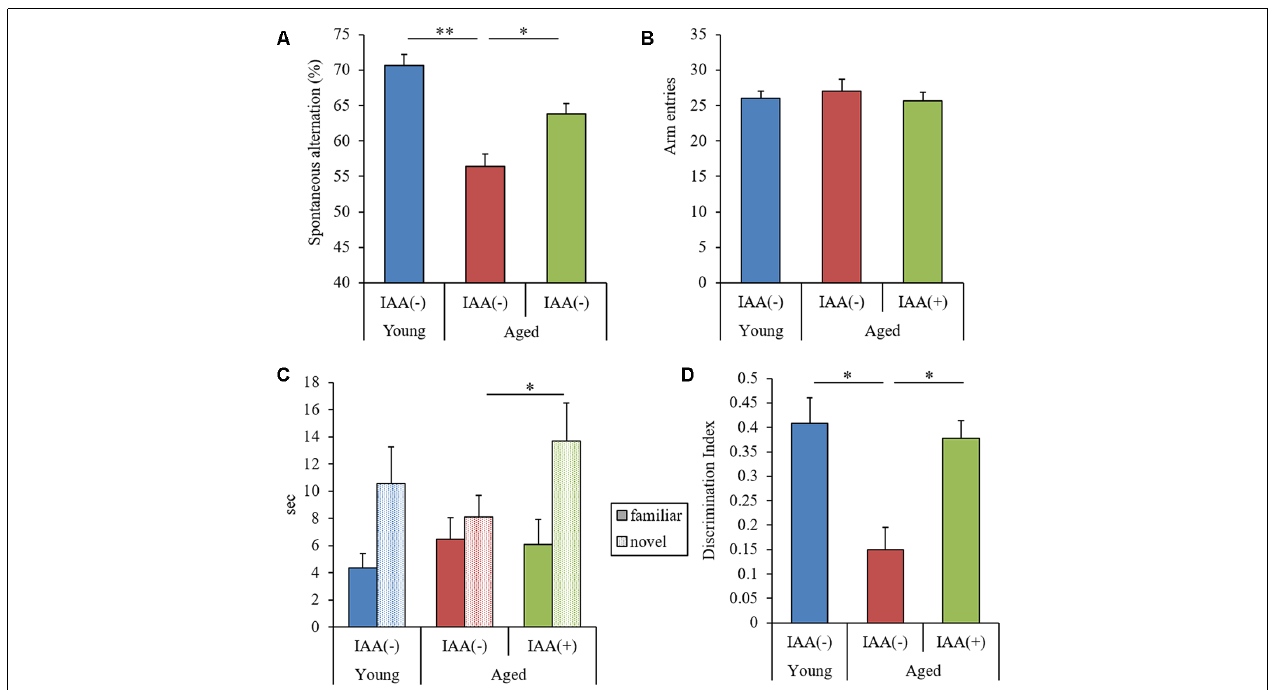
FIGURE 5 | Effects of the short-term administration of IAA in aged mice. C57BL/6J mice aged 7 months (young) and 22 months (aged) were orally administered 0 or 1 mg/kg IAA for 9 days. We performed behavioral characterization using the spontaneous alternation test at day 7 of administration and the NORT at days 8 and 9 at 1 h after the oral administration. For these behavioral tests, we used young mice ( n = 15) and aged mice with ( n = 14) and without ( n = 13) dietary IAA. (A,B) We measured spontaneous alternation score (A) and arm entries (B) in the Y-maze spontaneous alternation test to evaluate spatial memory. (C,D ) To evaluate object recognition memory, we measured the time taken to approach a novel or familiar object (C) and DI in NORT (D) . Data are presented as mean ± SE. We calculated the p -values shown in the graph by one-way ANOVA, followed by the Tukey-Kramer test. ∗ p < 0.05 and ∗∗ p <